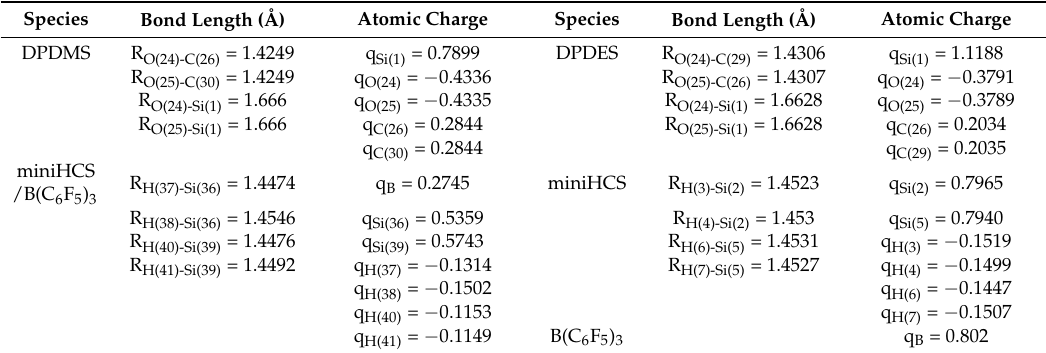
Table 2. Key parameters of various reactants and catalyst optimized at B3LYP/6-311G or STO-3G level. Species Bond Length (Å) Atomic Charge Species Bond Length (Å) Atomic